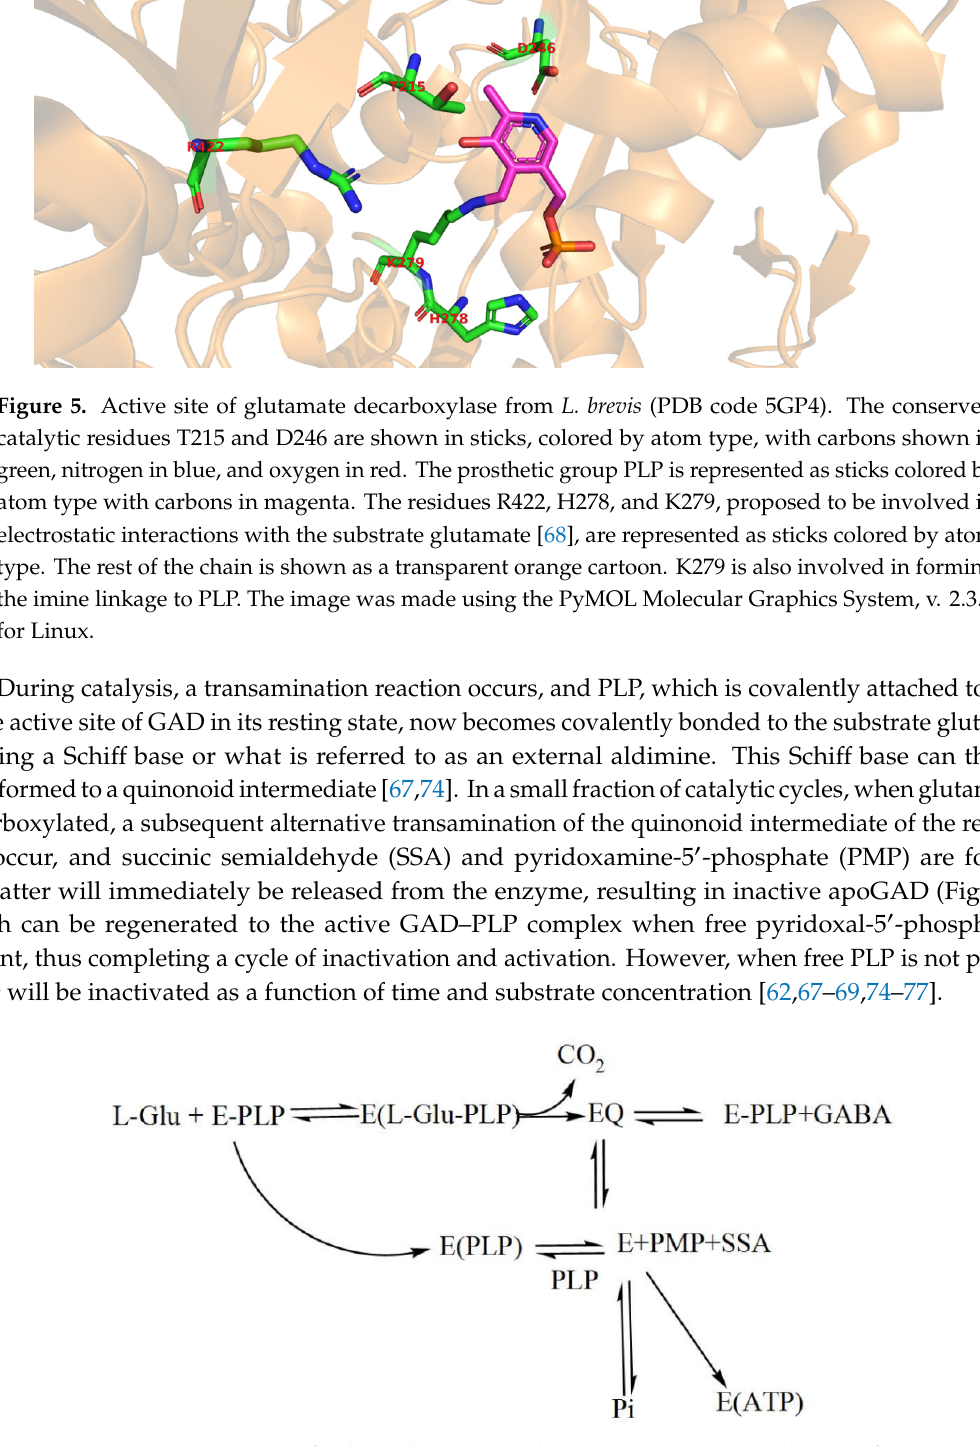
Figure 6. The interconversion of holo- and apoGAD. The primary reaction results in the formation of GABA and holoGAD remains intact and active. holoGAD reacting with PLP will activate a secondary reaction resulting in the formation of apoGAD. E, apoGAD; E-PLP, holoGAD; Pi, inorganic phosphate; EQ, quinonoid intermediate; PMP, pyridoxamine phosphate; PLP, pyridoxal-5 ′ - phosphate; SSA; succinic semialdehyde (modified from [76]).